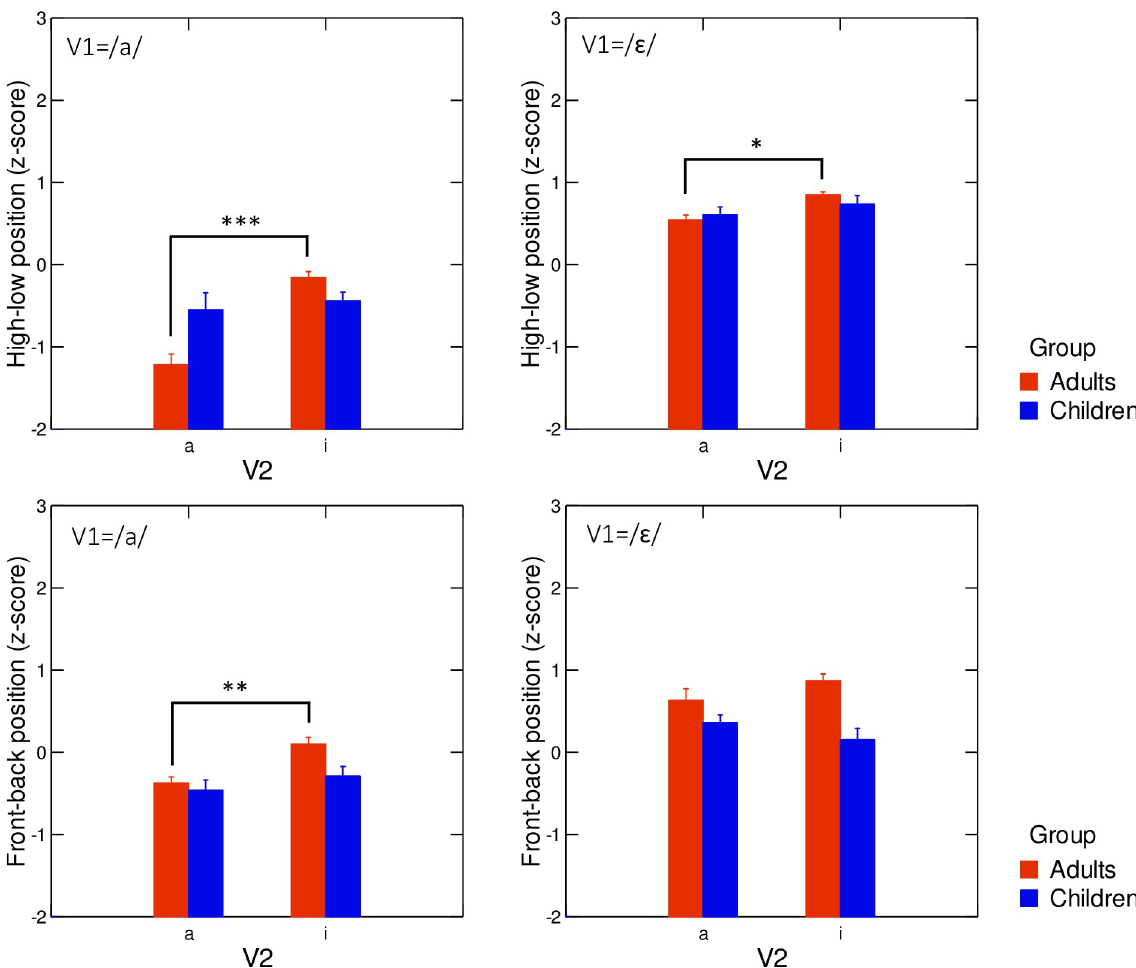
Fig 9. Average values of z-scored front-back (x, bottom row) and high-low (y, top row) positions of the highest point of the tongue in V 1 , across V 2 contexts (/a/ or /i/), for both participant groups (red columns: Adults, blue columns: Children). Left-hand panels: tokens for which V 1 = /a/; right-hand panels: tokens for which V 1 = / ε /. Error bars are standard errors of the mean.